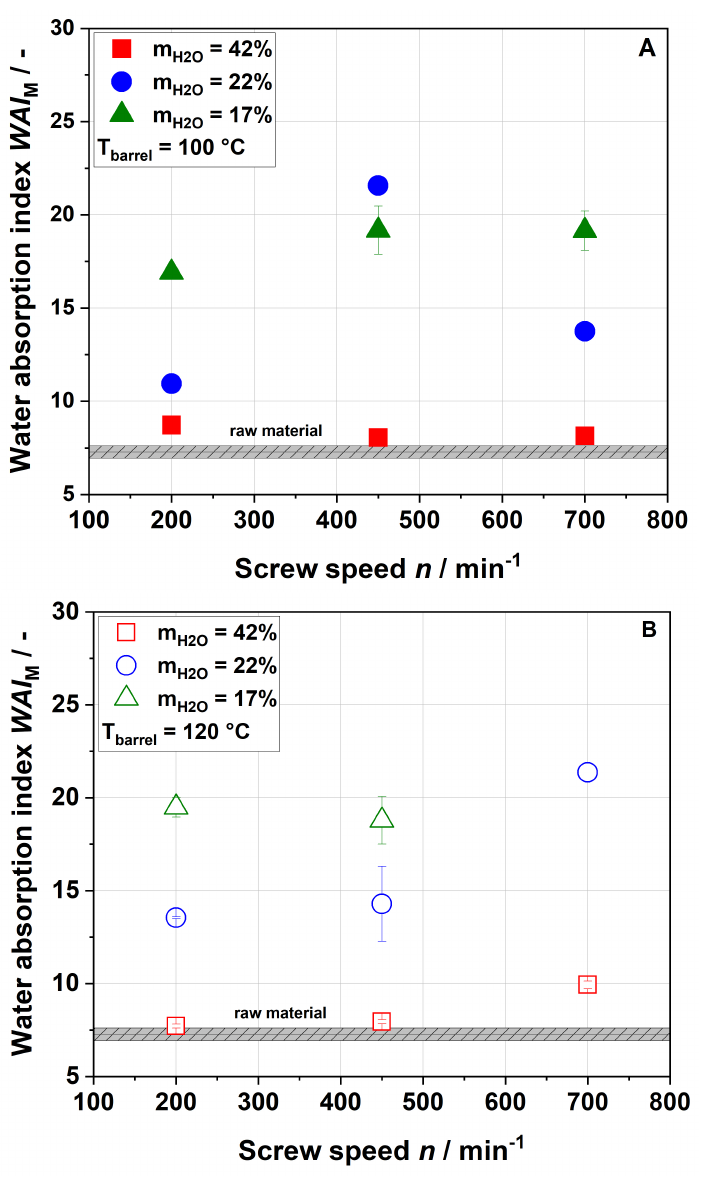
Figure 4. E ff ect of screw speed and water content on the modified water absorption index (WAI) at ( A ) 100 ◦ C barrel temperature and ( B ) 120 ◦ C barrel